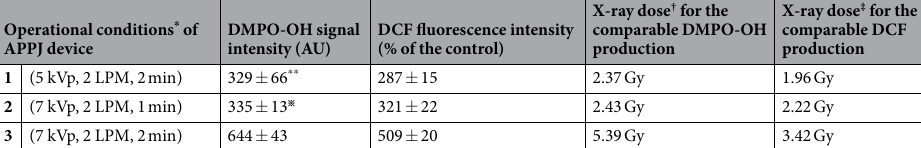
Table 1. DMPO-OH signal and DCF fluorescence intensities under three different parametric setups of APPJ device operation and the X-ray doses that would cause the comparable DMPO-OH and DCF signal intensities to plasma treatments. * (applied voltage, helium gas flow rate, duration of treatment). ** standard error. † X- ray dose derived as in Fig. 6(a). ‡ X-ray dose as in Fig. 6(b). ※ Data obtained by extrapolation from the data in Fig.